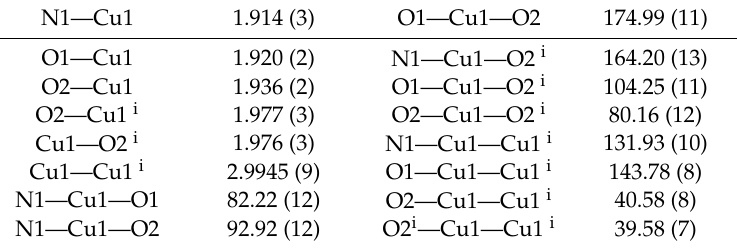
Table 2. Selected bond distances (Å) and angles ( ◦ ) in complex 1